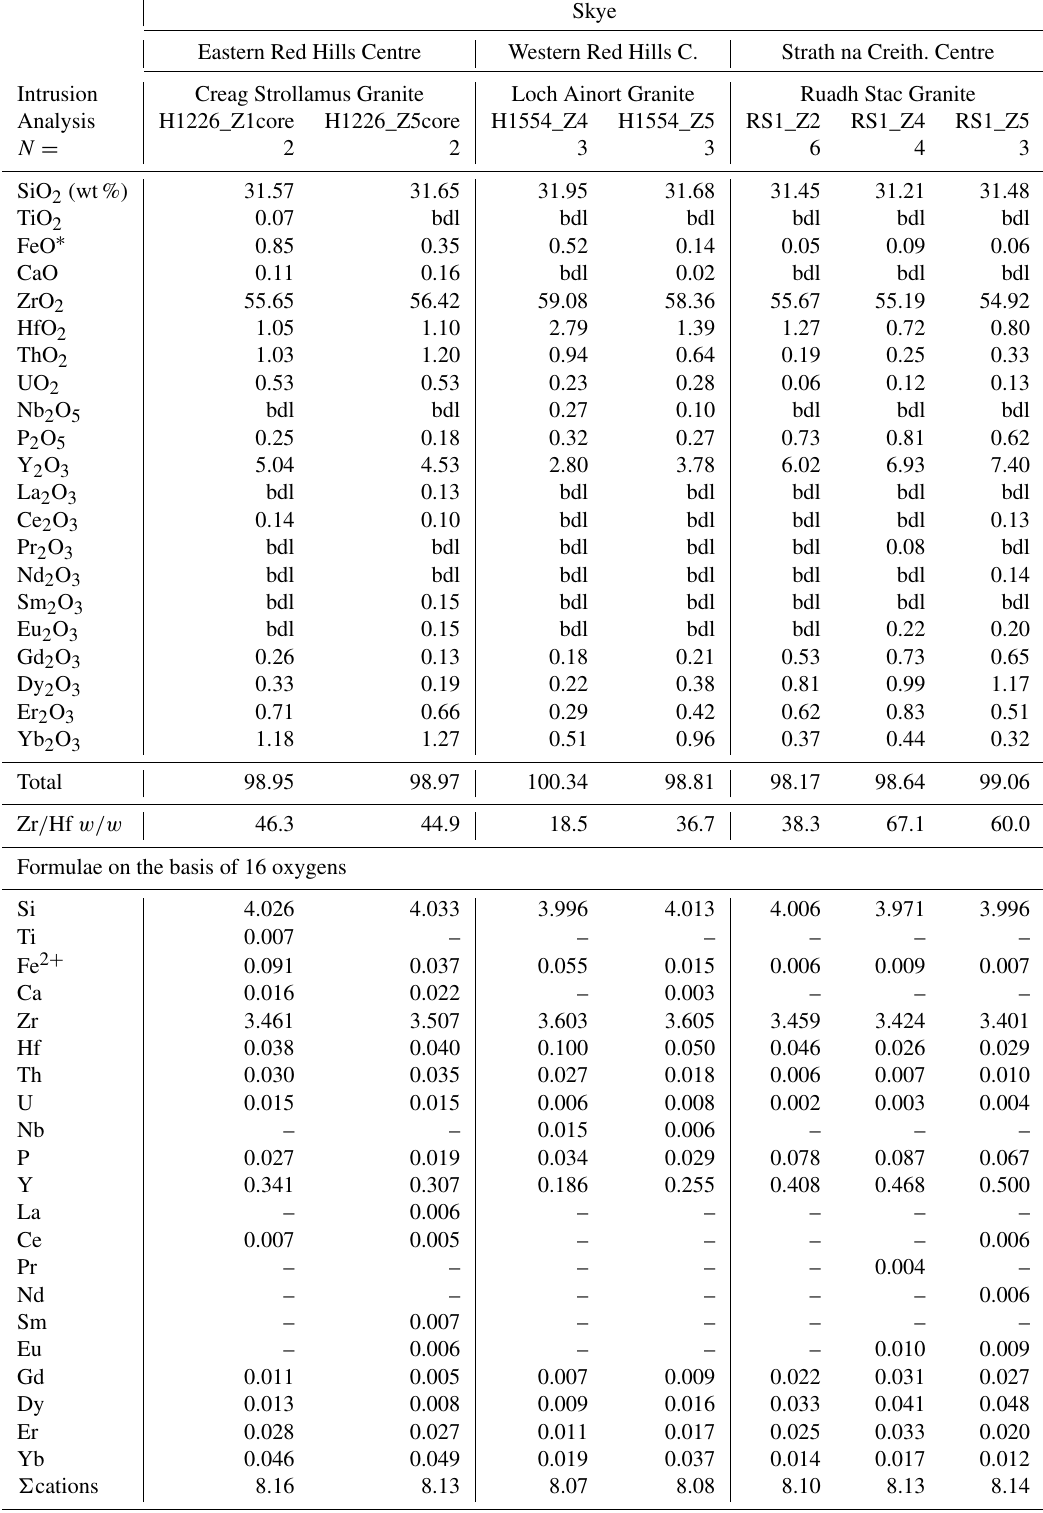
Table 6. Representative hydrothermal type 1 zircon compositions from Skye Skye Eastern Red Hills Centre Western Red Hills C. Strath na Creith. Centre Intrusion Creag Strollamus Granite Loch Ainort Granite Ruadh Stac Granite